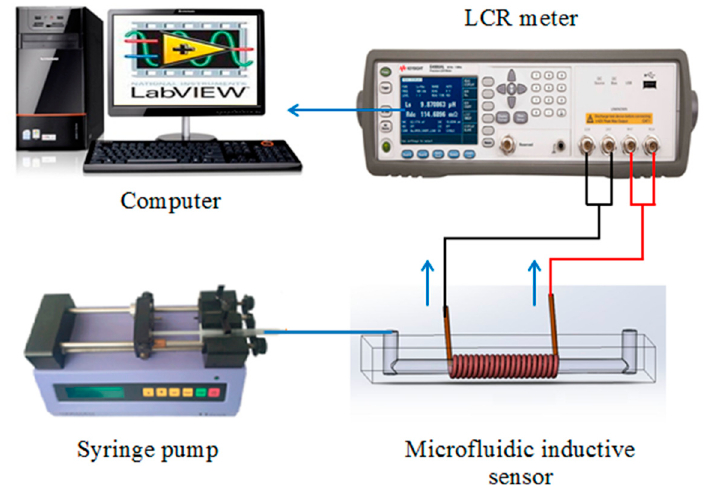
Figure 3. The impedance detection system.